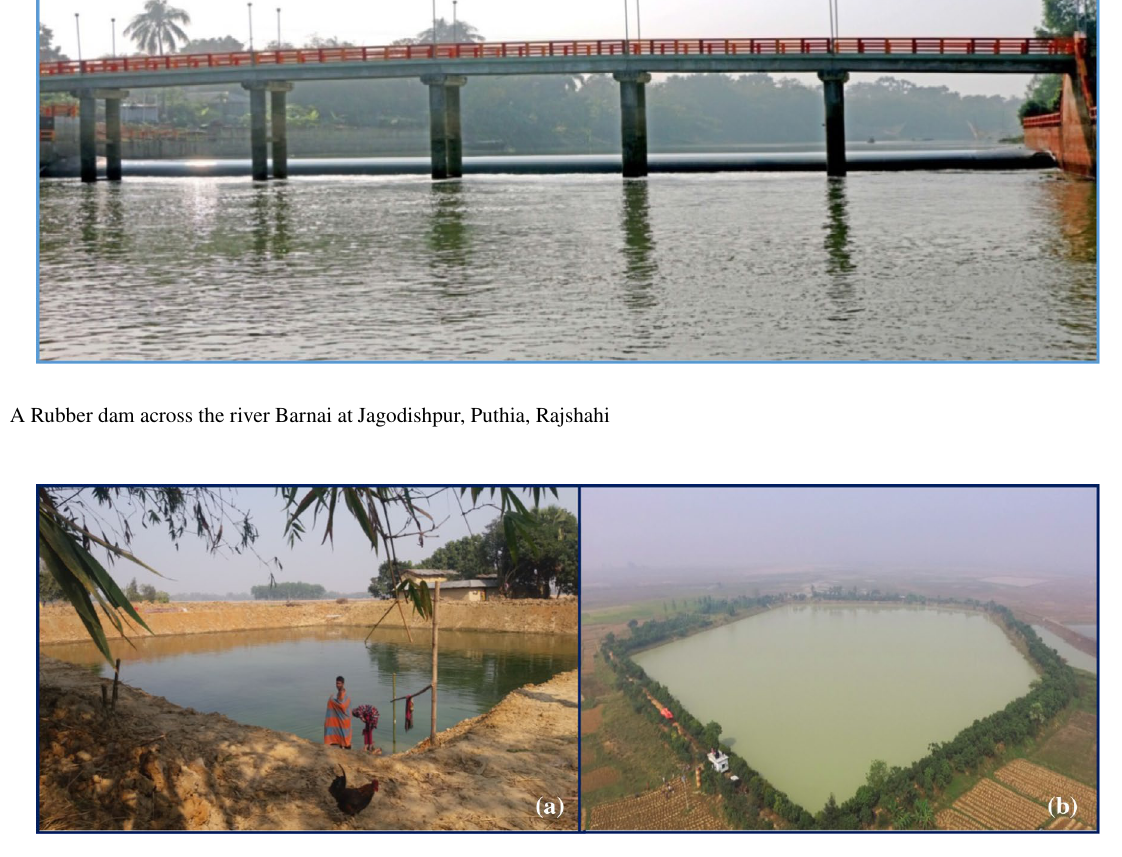
Fig. 4 Re-excavated ponds- a Konnyapara (Re-excavated area 1.09 acre), Niamatpur, b Kushumkunda (Re-excavated area 17 acre),